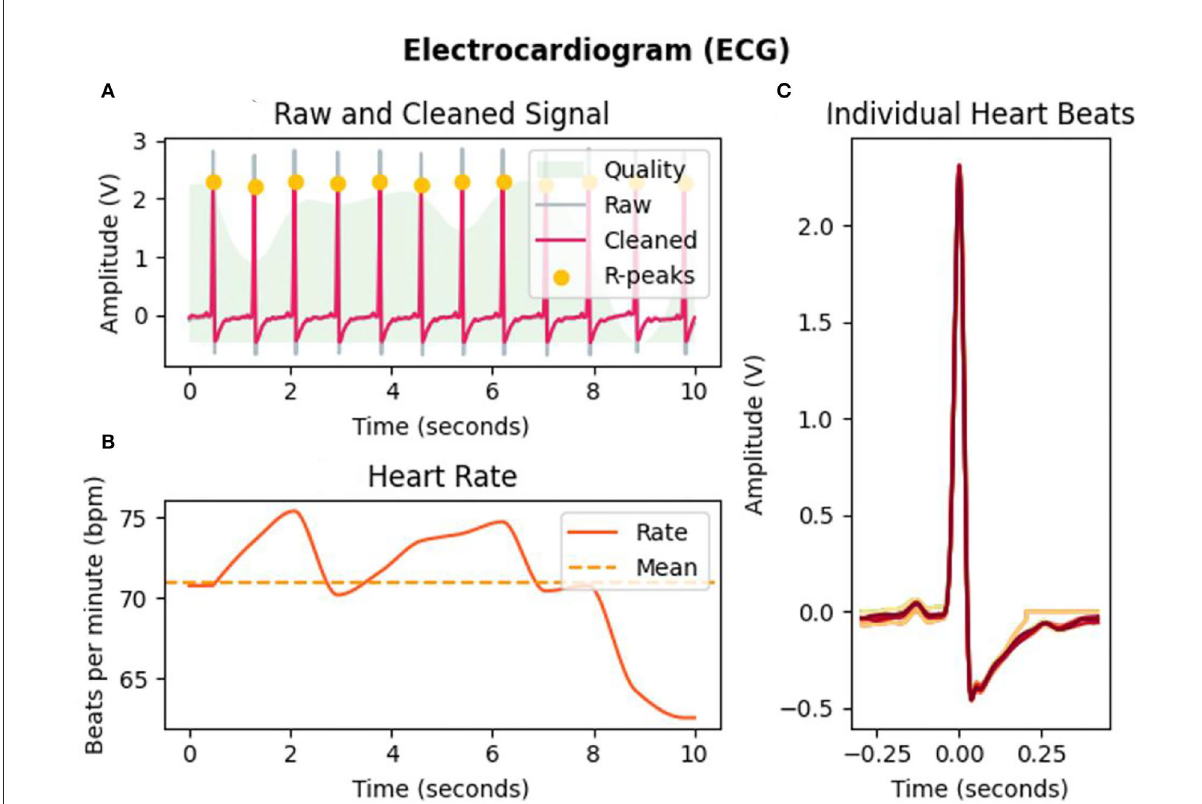
FIGURE1 ECG analysis of subject 1 in the selected interval (10s) of video b. (A) Filtering and R-peaks detection of ECG signals. (B) Heart rate changes during the selected interval. (C) Individual heartbeats.